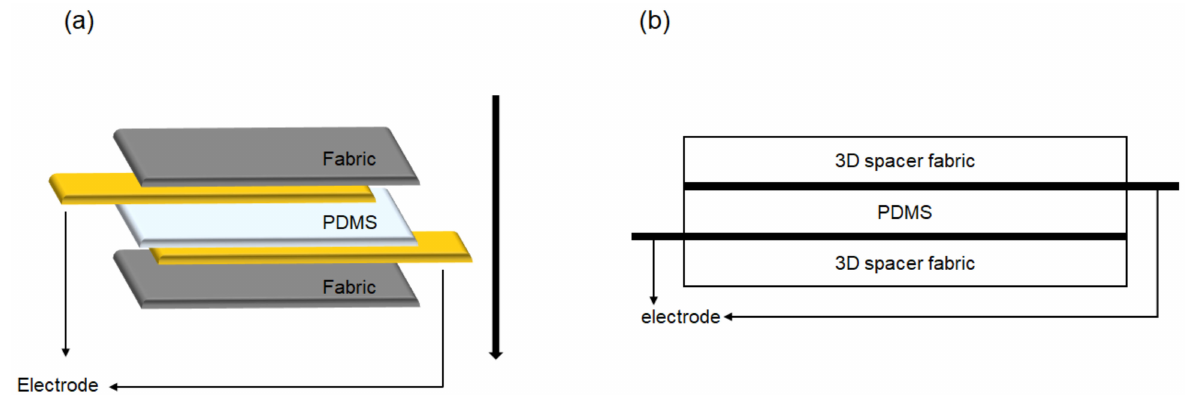
Figure 2. ( a ) The stacking order of the constituent fabric, PDMS, and electrode layers; ( b ) the TENG cross